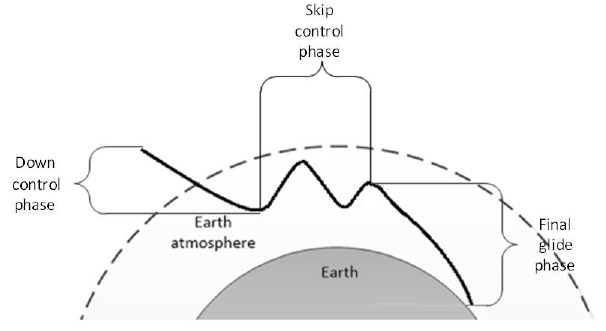
Figure 4. Skip re-entry sketch map.